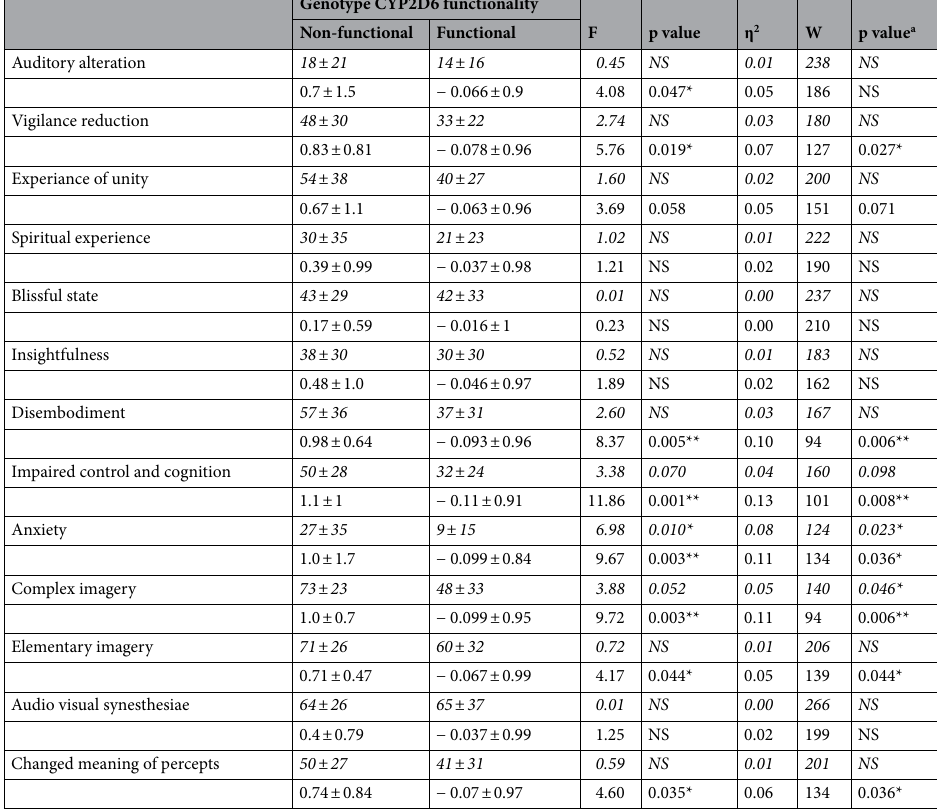
Table 1. Effects of genetically determined function of cytochromes P450 2D6 on the pharmacokinetics and response to LSD [mean ± SD (N)] with non-corrected statistics (non- and parametric) of the nominal values and z-scores (per study). Dose 1, including LSD 200 μg plus ketanserin in Study 4 was used for pharmacokinetic statistics; Dose 2, excluding LSD 200 μg plus ketanserin condition in Study 4 was used for all LSD effect statistics; N, number of subjects; SD, standard deviation; AUC, area under the time-concentration curve; */**/***asterisks indicate level of statistical significance p < 0.05/0.01/0.001; F, F-value of the Analysis of variance; NS, not significant; ∆, values are change scores from placebo; η 2 , eta square; W, Wilcoxon signed- rank test statistic; a p value of the Wilcoxon signed-rank test; cursive text shows nominal